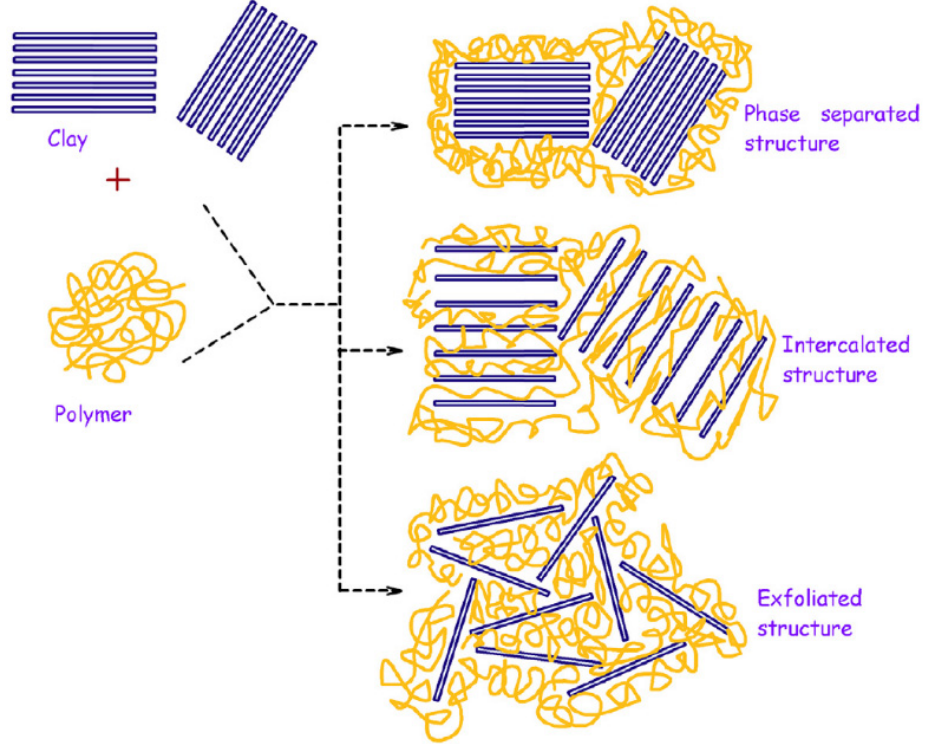
Figure 5. Schematic representation of composites produced from the interaction of layered silicates and polymeric networks. (Reprinted with permission from [48]. Copyright 2017, Elsevier).